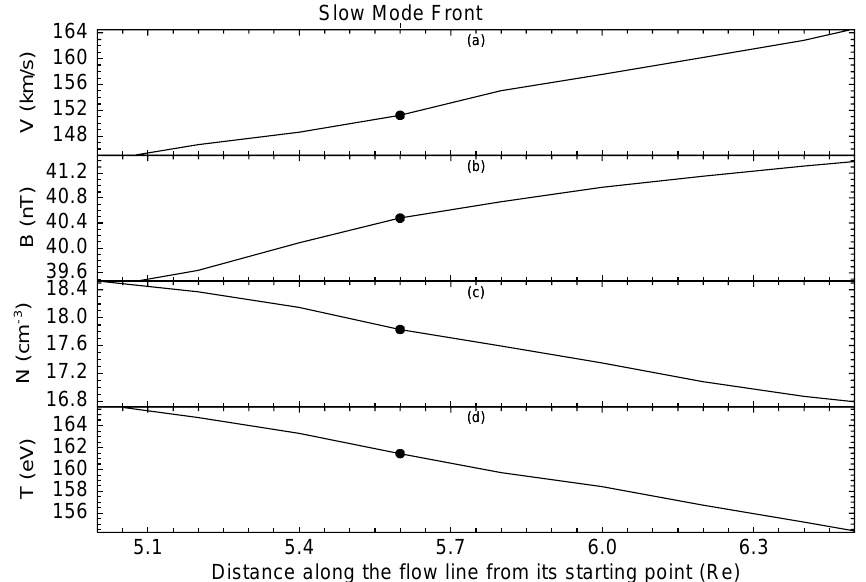
Fig. 15. A blowup of Fig. 14 around the black dot in the magnetosheath for a better view of the plasma and field transitions across the slow mode front along the green flow line in Fig.